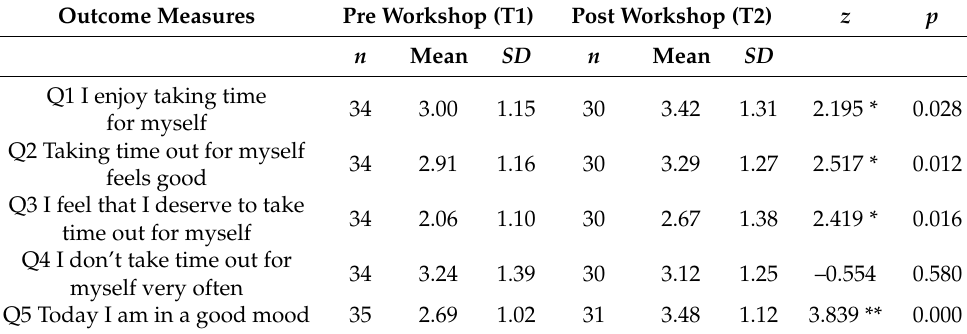
Table 1. A table showing patients outcome measures for T1 and T2, z -scores and p -values. Outcome